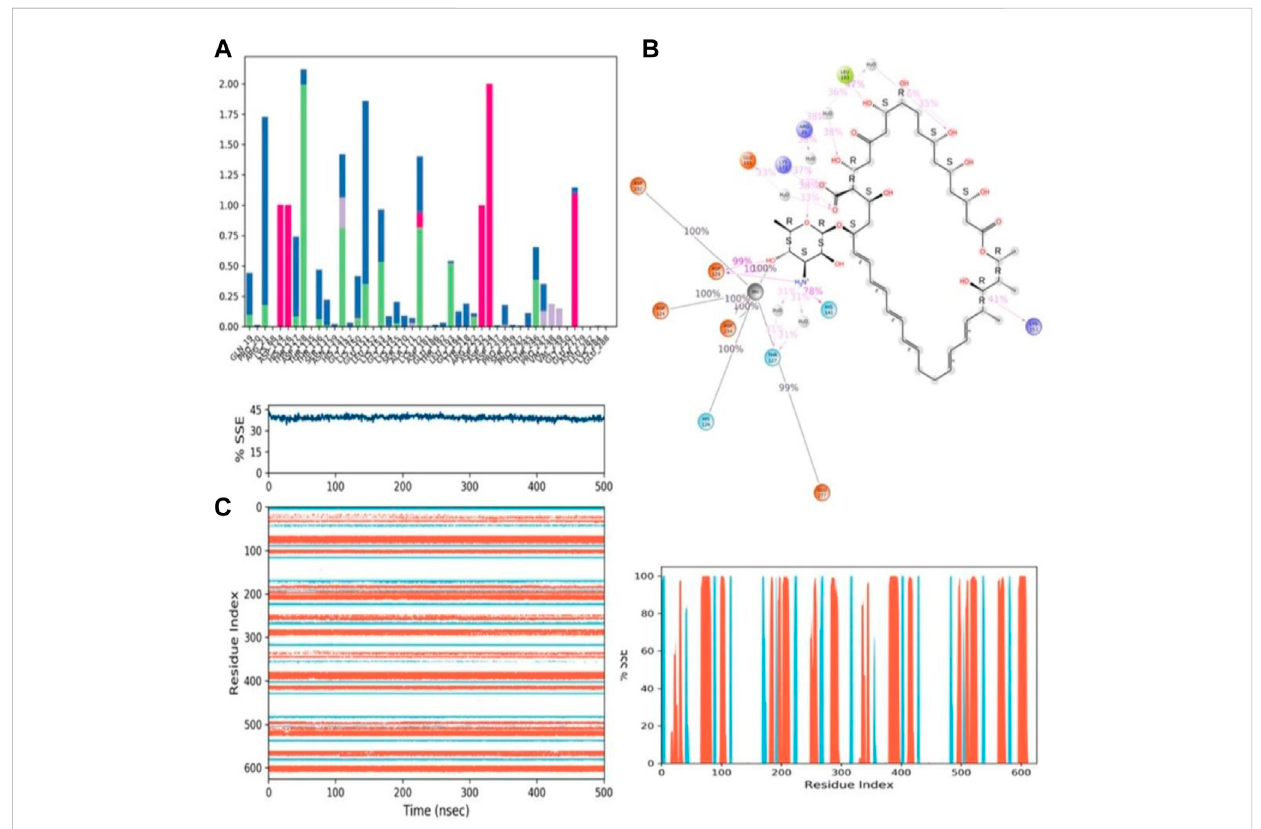
FIGURE 13 (A) Protein-ligand contact histogram (H-bonds, Hydrophobic, Ionic, Water bridges) of the PROTONATED STATE OF THE ligand, ZINC000252286875boundwith3KV2recordedina500 nssimulationinterval; (B) Ligandatominteractionswiththeproteinresiduesof3KV2boundwith ZINC000252286875; (C) Secondary Structure element distribution by residue index throughout the protein structure. Red indicates alpha helices, and blue indicate beta-strands of 3KV2 bound with protonated